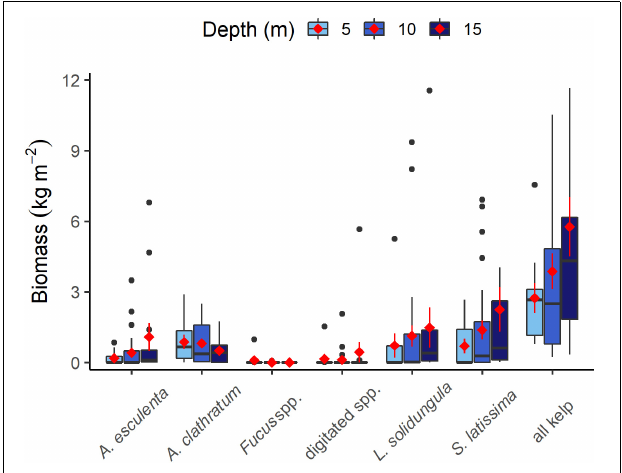
FIGURE 3 | Biomass for kelp species at 5, 10, and 15 m depths, at all sites. Final column shows total kelp biomass. Red diamonds are average over all sites ± SE, black line is median. Upper and lower bars of boxplot show first and third quartiles, upper whiskers show 1.5 IQR. Digitated category includes Laminaria digitata and Hedophyllum nigripes